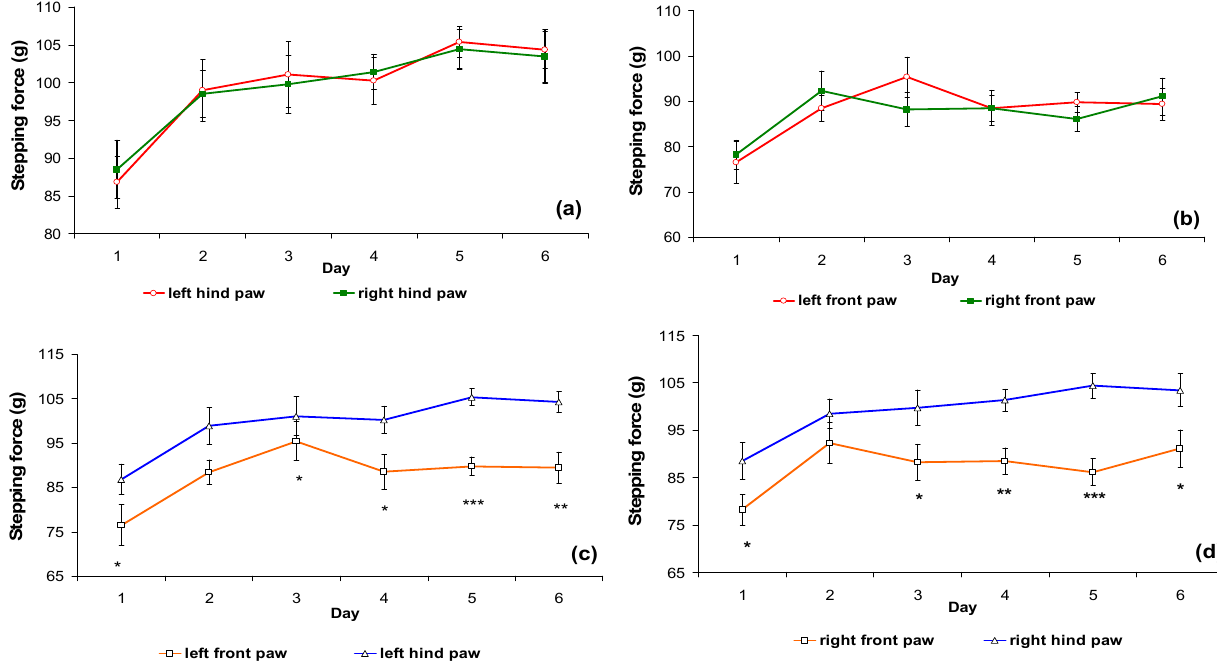
Figure 2. Comparison of stepping forces. ( a ) Left and right hind paws, ( b ) left and right front paws, ( c ) left front and hind paws, ( d ) right front and hind paws. (N = 6) * P < 0.05, ** P < 0.01, *** P < 0.001 between the